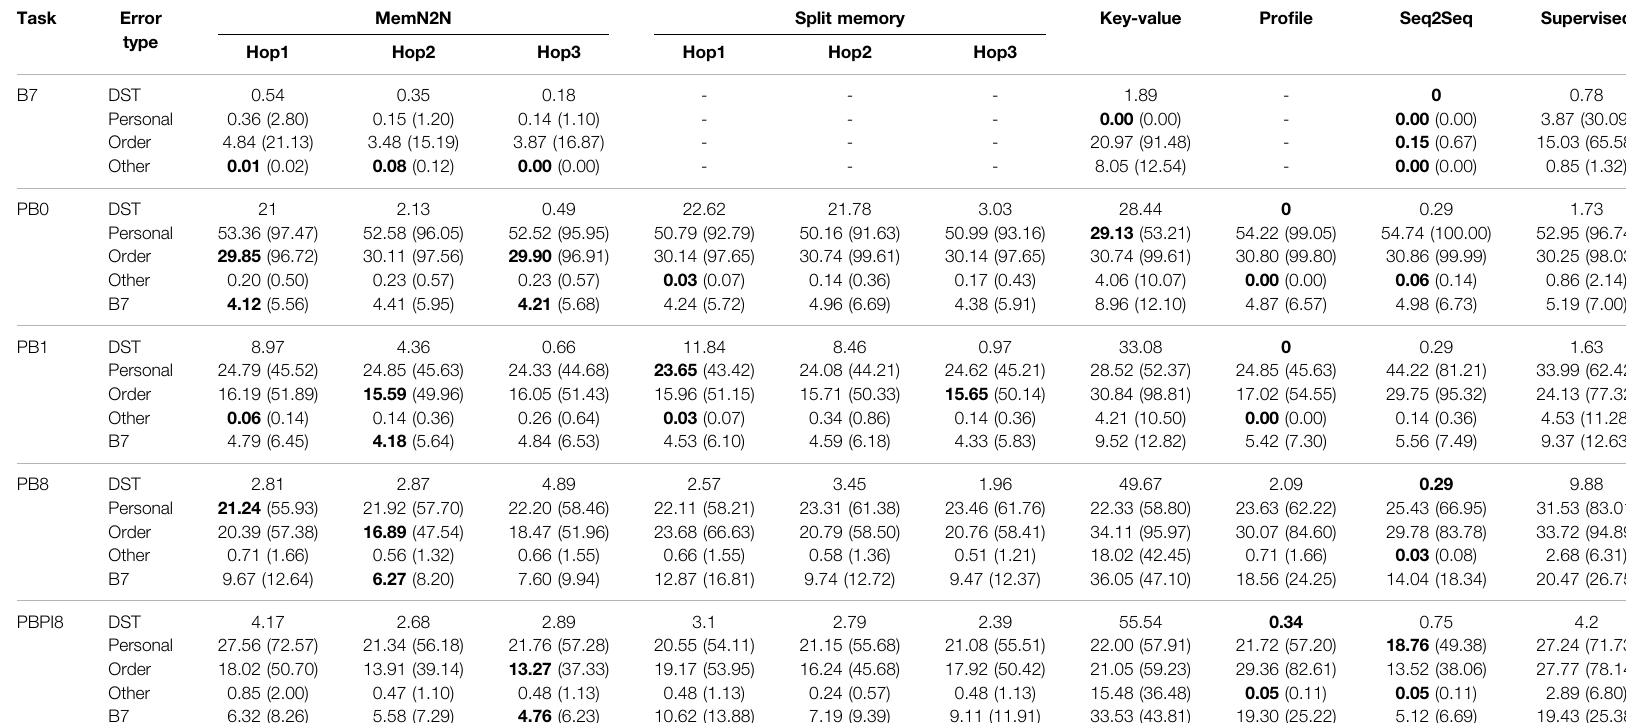
TABLE 5| Percentage oferrors indialogue state tracking (DST), personal(ised) , order details , other and Barista Task 7(B7) phrase types for 1,000 dialogue test sets. The best performing methods (or methods within 0.1%) are given in bold for the error in per-response accuracy, and the error percentage within the phrase type is given in parentheses.